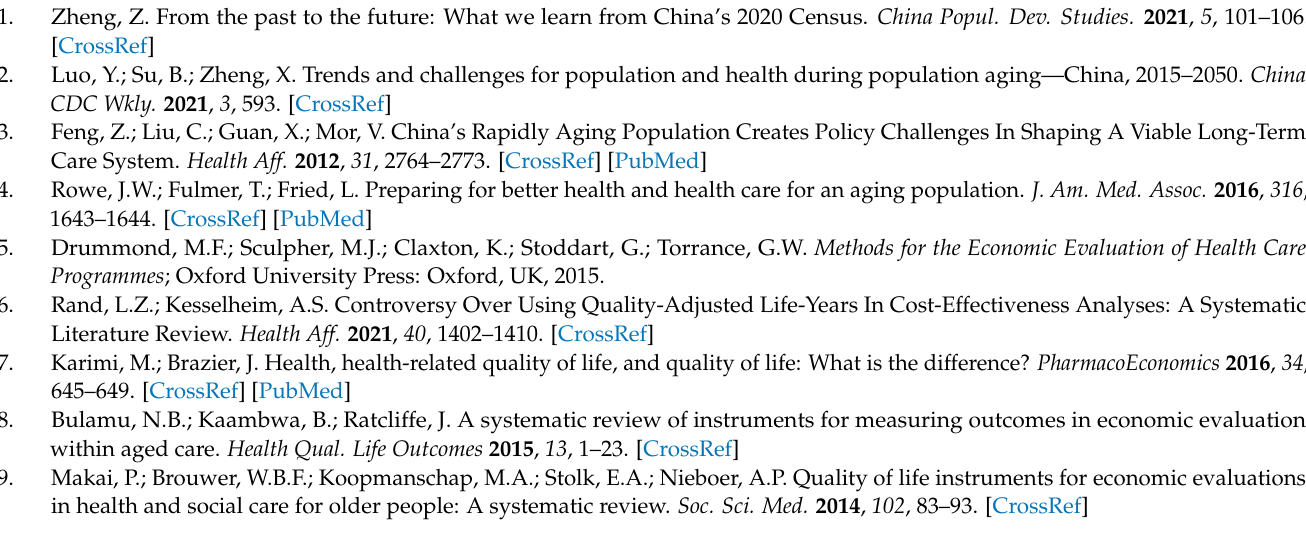
Table S2: Ordered logistic model of the effect of demographic variables on WOOP item